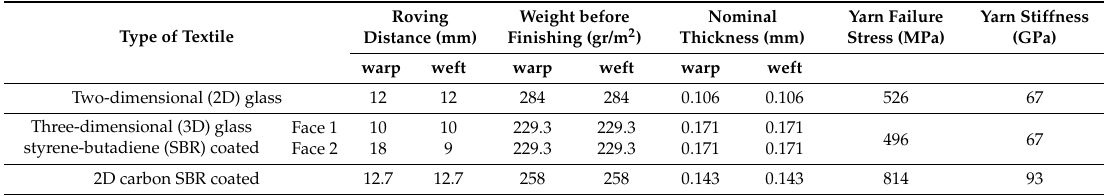
Table 1. Geometrical and mechanical data of the reinforcing